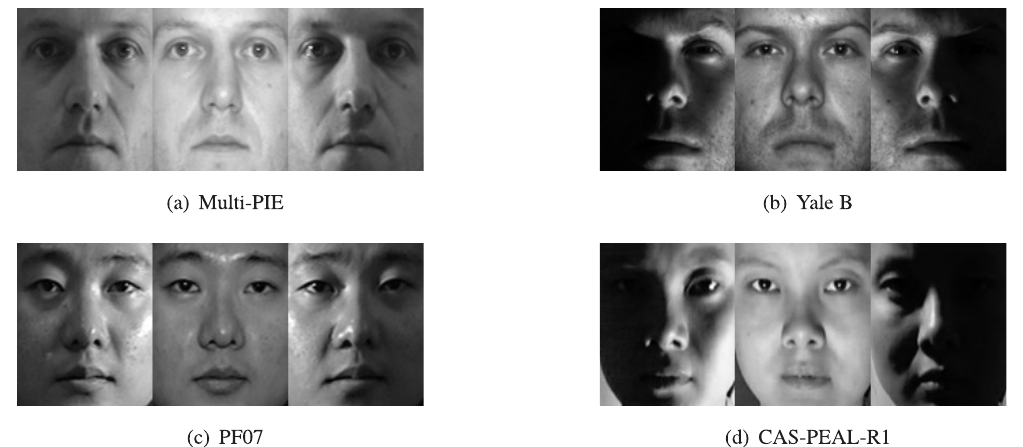
Figure 8. Sample images of each database: ( a ) Multi-PIE; ( b ) Yale B; ( c ) PF07; and ( d )